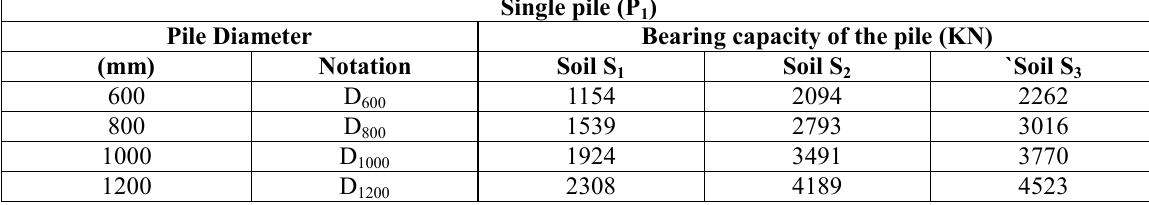
Bearing capacity of single pile of varying diameters in three types of soil.